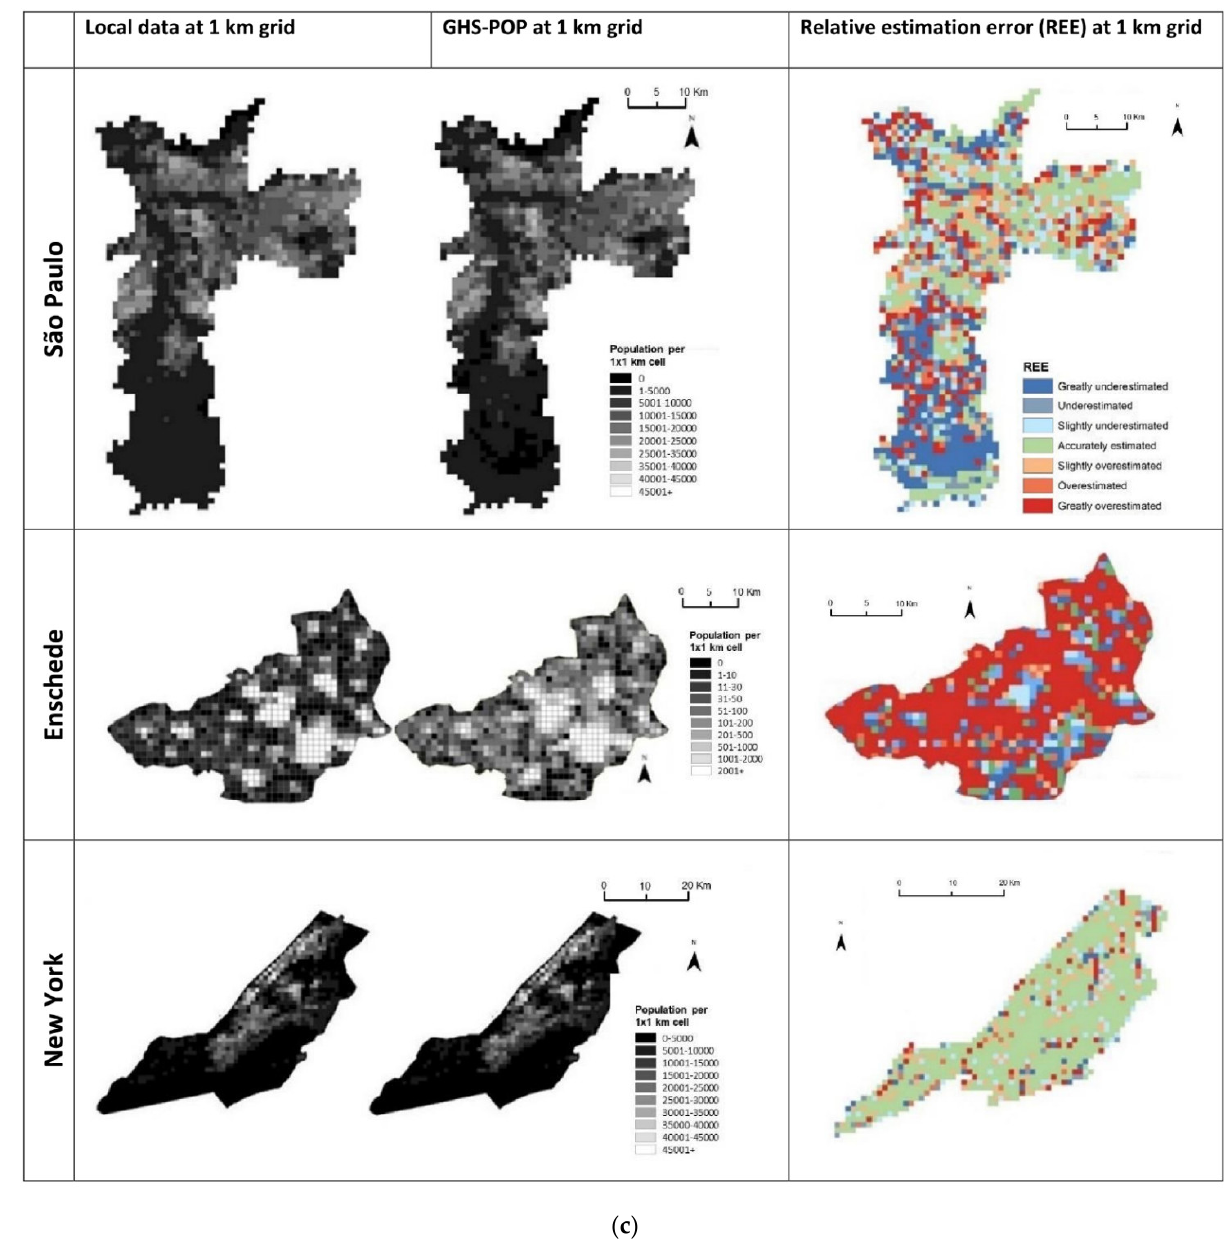
Figure 2. Average population count in a 1 × 1 km grid distribution for local and GHS-POP data and spatial distribution of relative estimation error (REE): ( a ) African cities, ( b ) Asian cities, ( c ) American and European cities.